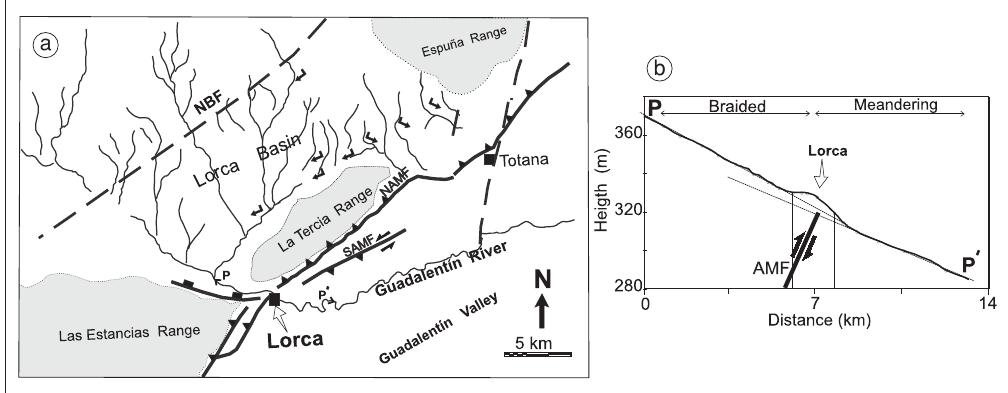
Fig. 7a,b. a) Drainage network of the Guadalentín River in the vicinity of the Lorca-Totana section of the Alhama de Murcia Fault Zone. The white arrow shows the point along the Guadalentín River where a change in the fluvial pattern (from braided to meandering) is observed. This change coincides with a change of slope in the longitudinal profile of the river (b), and take place crossing Ahama de Murcia Fault (AMF). This profile was drawn using 1:10 . 000 topographic maps. NBF - Northbetic Fault. Black arrows show the deflection of a Pliocene fluvial network due to the tectonic uplift of La Tercia